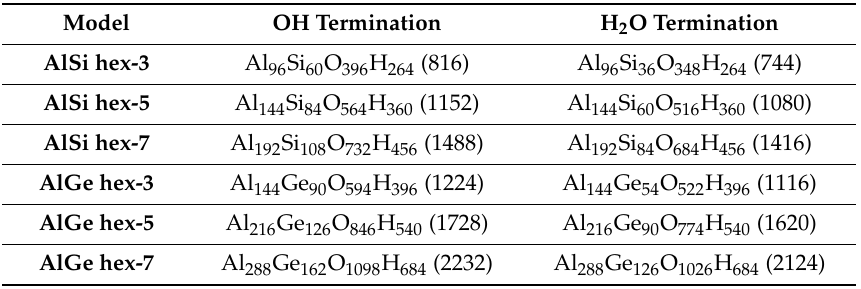
Table 1. Full stoichiometry for the hex-3, 5 and 7 models of the OH- and H 2 O-terminatied AlSi and AlGe NTs. The total number of atoms of the model is shown in